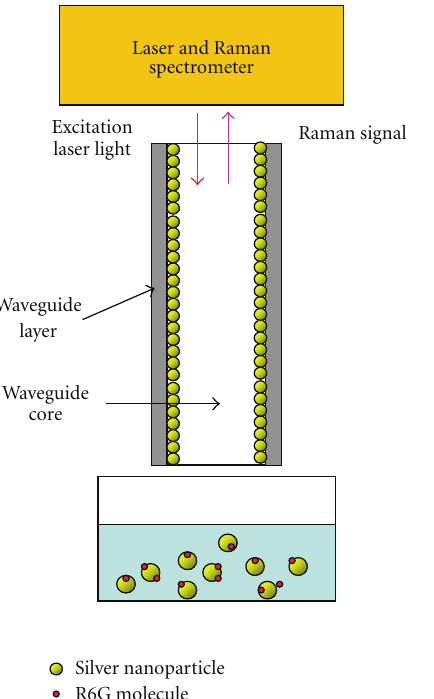
Figure 8: Comparison of SERS spectra of R6G at the concentration of 10 − 6 M between direct sampling and using a 2 mm liquid-filled